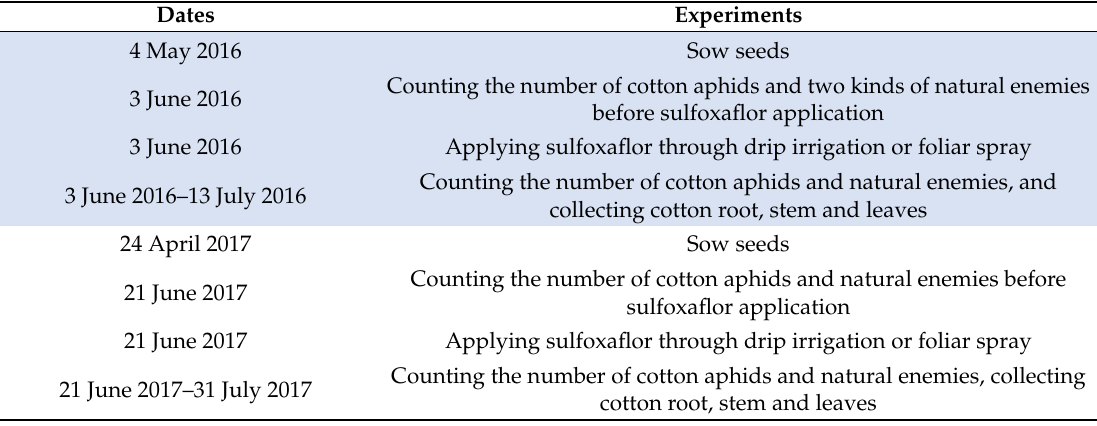
Table 1. Timeline of field experiments conducted in 2016 and